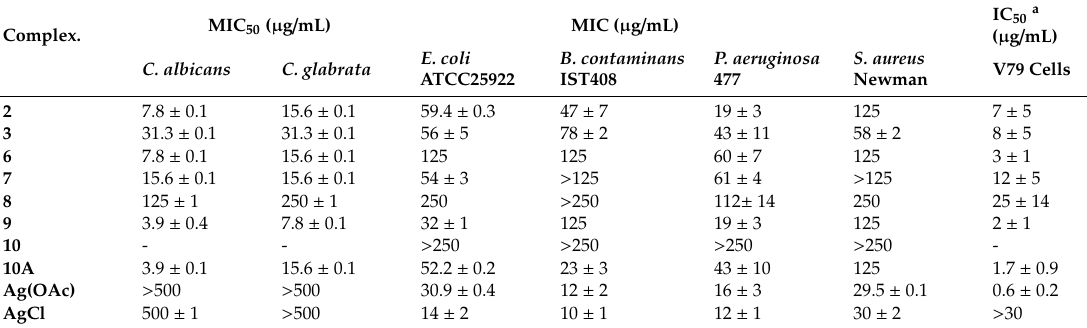
Table 3. Biological values assessed for the camphorimine silver